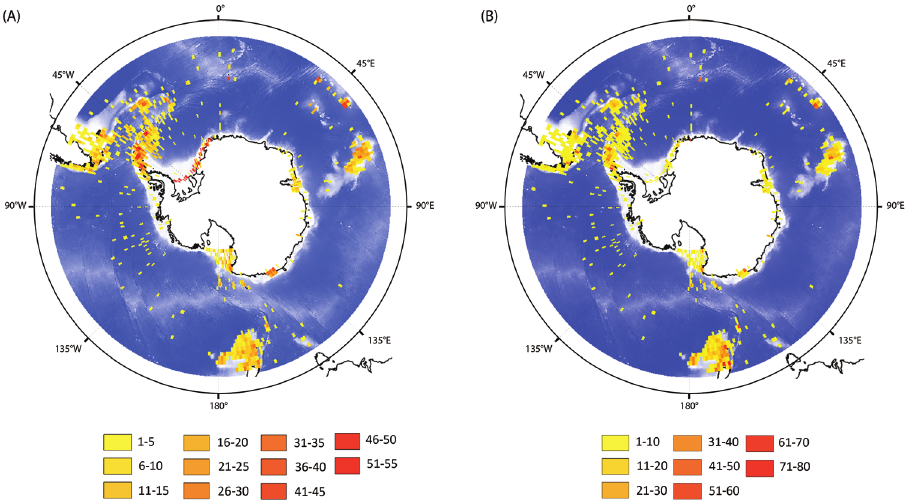
Figure 2. A Species richness in the Southern Ocean. The number of asteroid species present in 1° × 1° grid cells are reported using yellow-red colour chart B Sampling effort in the Southern Ocean for the class Asteroidea. The number of sampling station per 1° × 1° grid cell is reported using yellow-red colour chart. Projection: South Pole